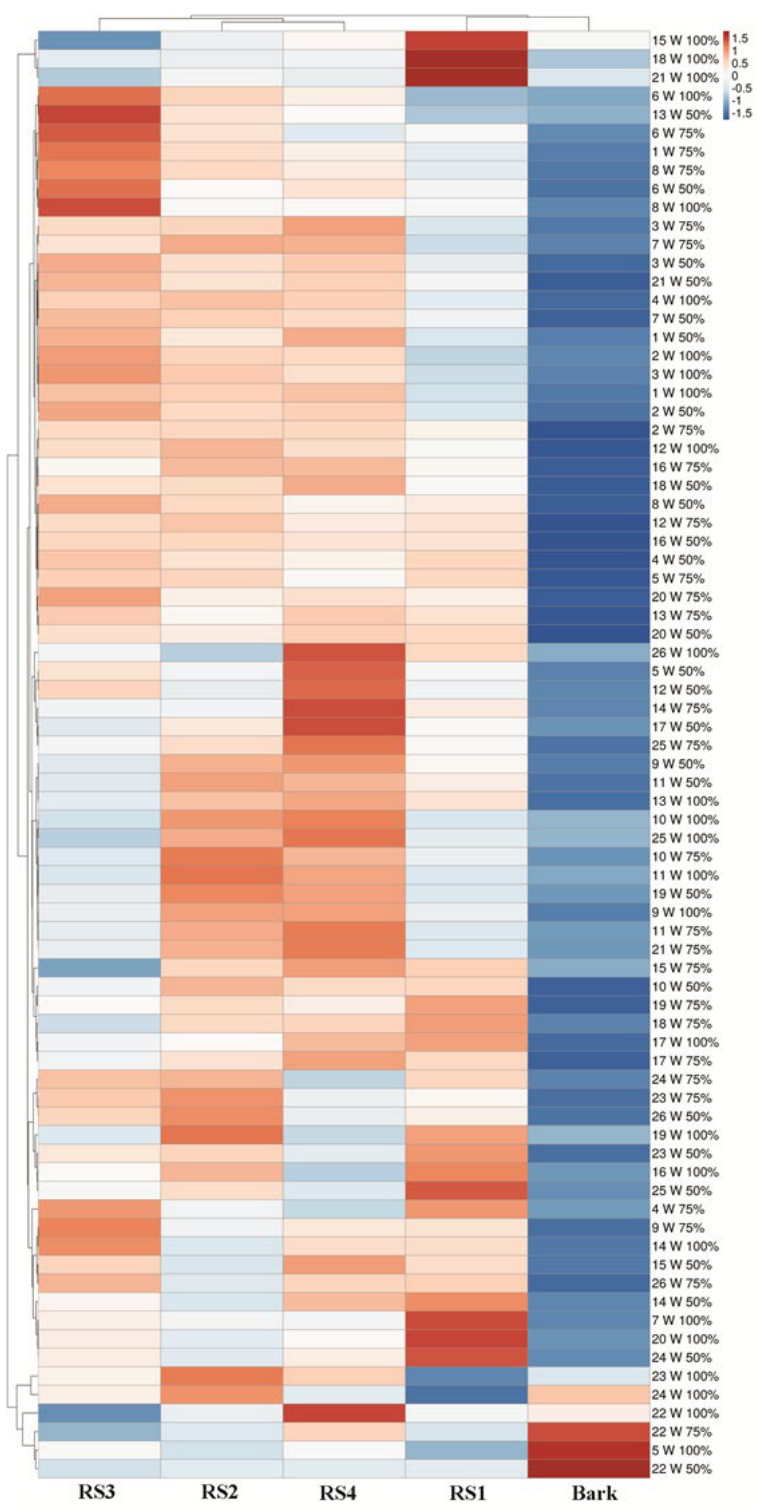
Figure 5. Heat map depicting clustering of tomato rootstocks based on: shoot fresh weight (1), shoot dry weight (2), shoot length (3), number of leaves (4), SPAD reading (5), root length (6), root fresh weight (7), root dry weight (8), number of fruit/plant (9), mean fruit weight (10), total yield/plant (11), vitamin C content (12), TSS (13), firmness (14), N (15), P (16), K (17), Ca (18), Mg (19), Fe (20), GA 3 (21), ABA (22), proline (23), APX (24), DHAR (25), and POD (26) under different water regimes.